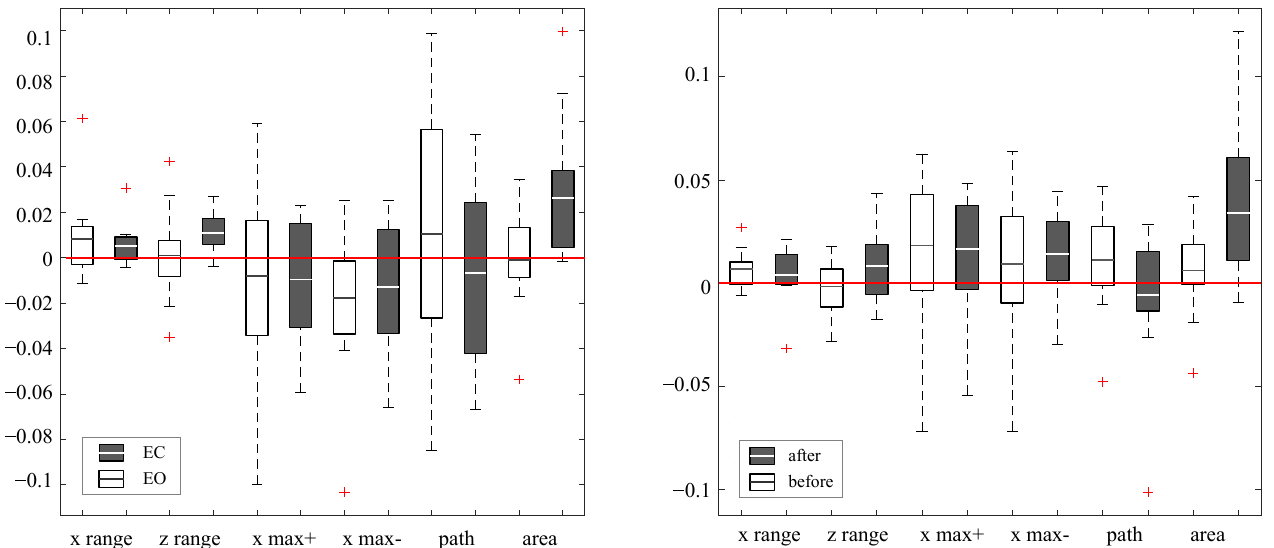
Figure 4. ( a ) The box plot shows the differences between the before- and after-dancing sessions in the averaged COP parameters distinguished by the EC and EO conditions. ( b ) The box plot shows the differences in between the two visual feedback conditions (EO and EC) in the averaged COP parameters by separated before - and after -dance session values. Note that the difference in the path of COP was downscaled to a hundredth and the difference in the COP area upscaled by fifty-fold. The numeric data are detailed in Supplementary Material